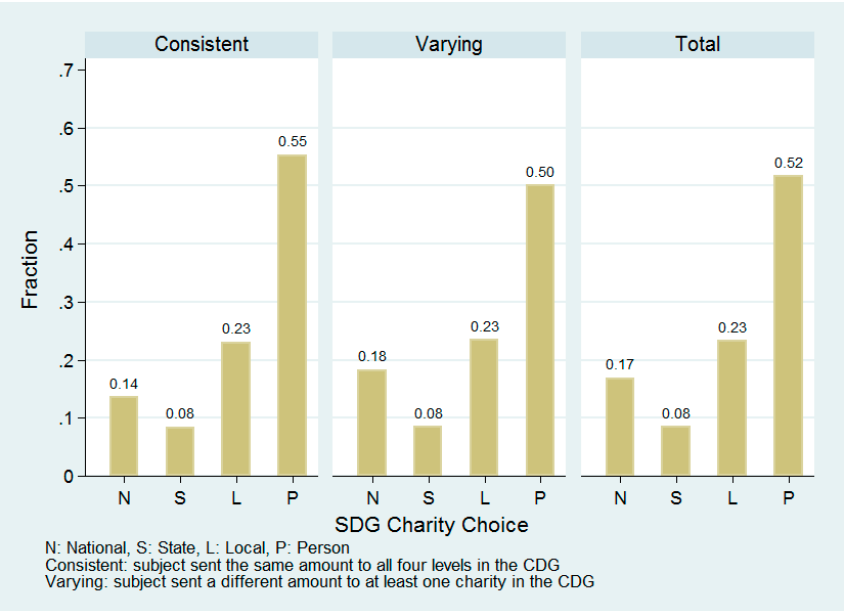
Figure 4. Proportion of subjects that chose each level in the SDG: consistent givers, varying givers, and the full sample.